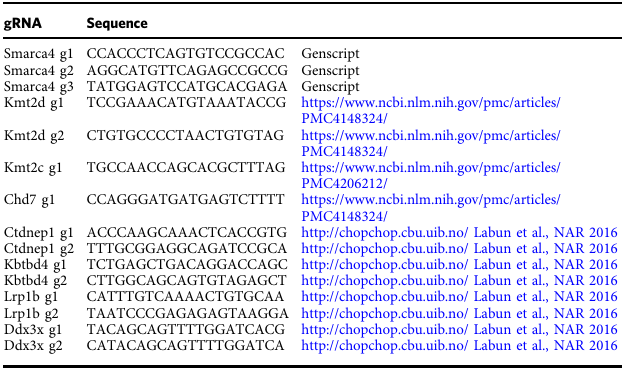
Fig. 4 Cerebellar organoids electroporation with G fi 1 / c-MYC and Otx2 / c-MYC induces overproliferation. a Schematic representation of organoids electroporation. b Bright fi eld and fl uorescence images of cerebellar organoids at day 60 electroporated at day 35 with pPBVenus. c Bright fi eld and fl uorescence images of cerebellar organoids at day 60 electroporated at day 35 with pPBase + pPBMyc + pPBG fi 1 + pPBVenus. d Bright fi eld and fl uorescence images of cerebellar organoids at day 60 electroporated at day 35 with pPBase + pPBMyc + pPBOtx2 + pPBVenus. Arrows in ( b , c , d ) indicate Venus-positive cells. e Confocal images of GFP (Venus) and PCNA immuno fl uorescence of cerebellar organoids at day 60 electroporated at day 35 with pPBase + pPBVenus + pPBMyc and pPBOtx2. Arrows indicate double-positive cells. f Confocal images of GFP (Venus) and β 3-tubulin immuno fl uorescence of cerebellar organoids at day 60 electroporated at day 35 with pPBase + pPBMyc + pPBOtx2 + pPBVenus. Arrows indicate β 3- tubulin-negative cells. g Quanti fi cation of cerebellar organoids at day 60, electroporated at day 35 with either pPBVenus or pPBase + pPBMyc + pPBOtx2 + pPBVenus (OM) or pPBase + pPBMyc + pPBG fi 1 + pPBVenus (GM). n = 6 biologically independent organoids. h Quanti fi cation of cerebellar organoids at day 40, electroporated at day 35 with either pPBVenus or pPBase + pPBMyc + pPBOtx2 + pPBVenus (OM) or pPBase + pPBMyc + pPBG fi 1 + pPBVenus (GM). n = 6 biologically independent organoids. Error bars in ( g , e ) represent standard error of the mean. Scale bars 250 µ m in ( b – d ),100 µ m in ( e , f ). Paired Student's t test, two tails. * p -value < 0.05, ** p -value < 0.01. *** p -value <